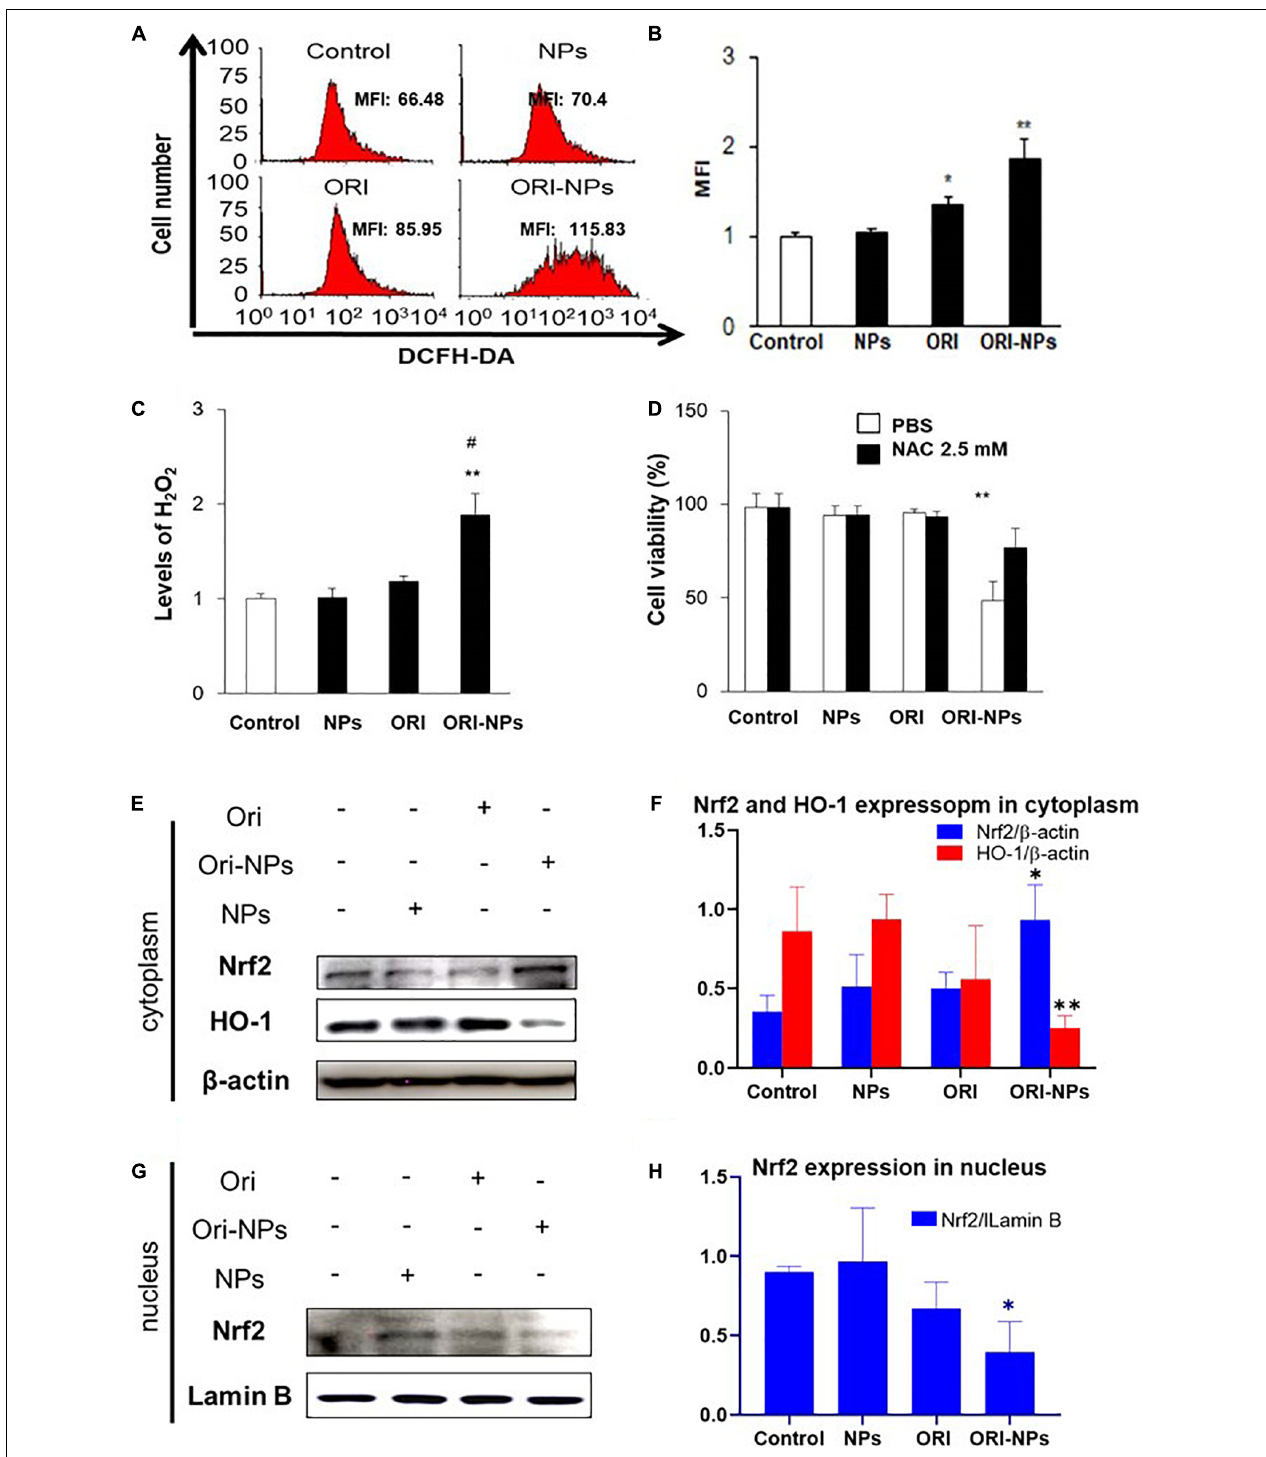
FIGURE 4 | ORI-NPs inhibit MCF-7 cell growth through ROS and Nrf2/HO-1 pathway. (A,B) ROS levels in MCF-7 cells treated with drugs for 24 h were measured using flow cytometry. (C) H2O2 levels in MCF-7 cells following 24 h treatment with drugs. (D) The viability of MCF-7 cells at 24 h treatment with drugs and followed treatment with ROS scavenger, NAC. (E) Representative western blot and (F) quantification of Nrf2 and HO-1 expression in cytoplasm of MCF-7 cells after 24 h treatment with blank NPs, ORI and ORI-NPs. (G) Representative western blot and (H) quantification of Nrf2 and HO-1 expression in nucleus of MCF-7 cells after 24 h treatment with blank NPs, ORI and ORI-NPs. β -actin and Lamin B were used as a loading control of proteins in cytoplasm and nucleus, separately. (Data were representative three independent experiments * P < 0.05 and ** P < 0.01 versus untreated control; # P < 0.05 versus ORI).